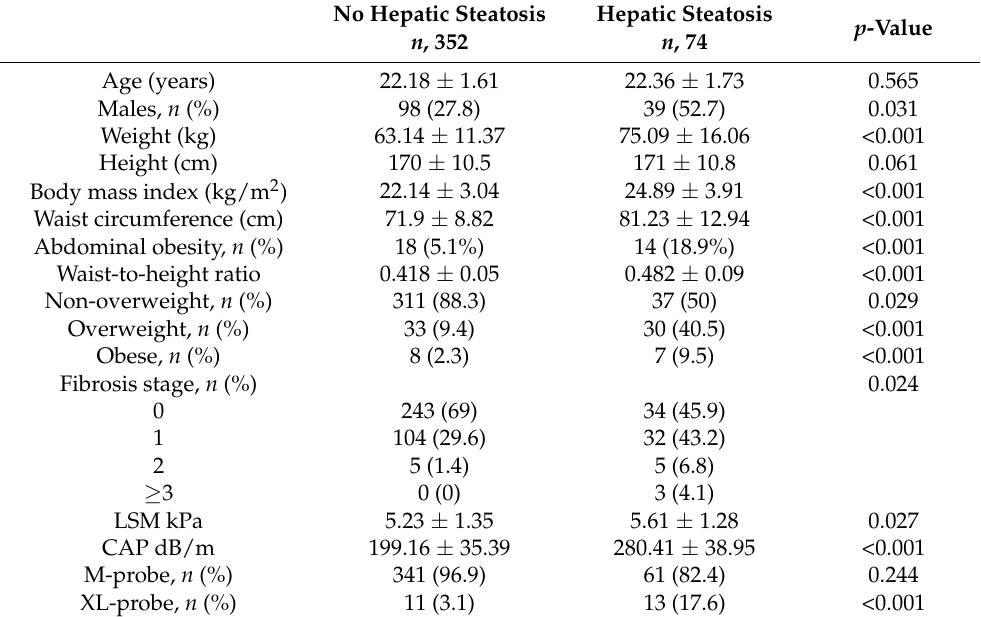
Table 3. Baseline characteristics of participants according to the presence of liver steatosis.